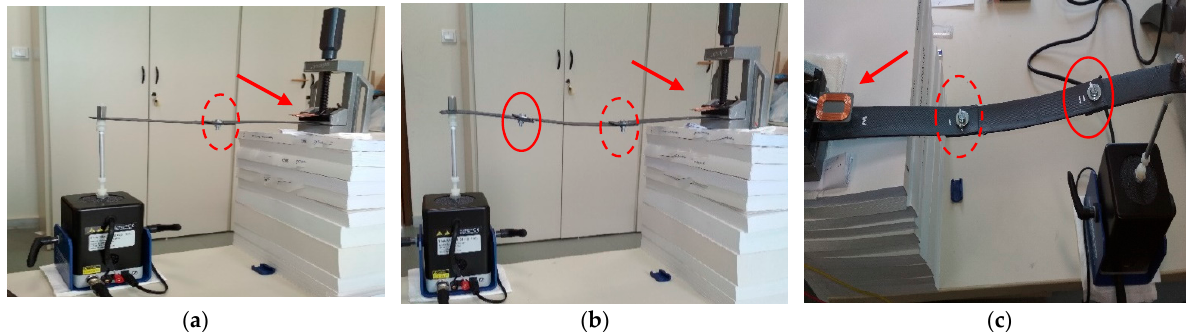
Figure 2. ( a ) Structure-A formed by two slabs connected in-series and clamped at one end; ( b ) Structure-B formed by three slabs connected in-series and clamped at one end; ( c ) top view of structure-B showing locations of MetGlas ® strip (marked with Σ ) and the bolts (marked with I and II, respectively) of joints J1 and J2. The reception coil (indicated by red arrows) is suspended above the strip position, J1 and J2 are indicated by red ellipses (dashed-solid, respectively) and the free end is supported/vibrated via the